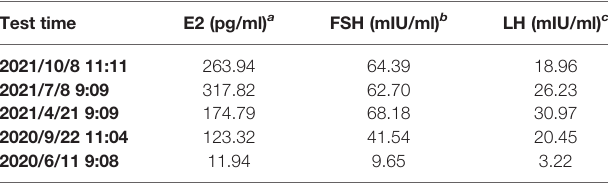
TABLE 2 | The concentration variations of the patient ’ s serum gonadal hormone during antihormonal therapy in immunoassay. Test